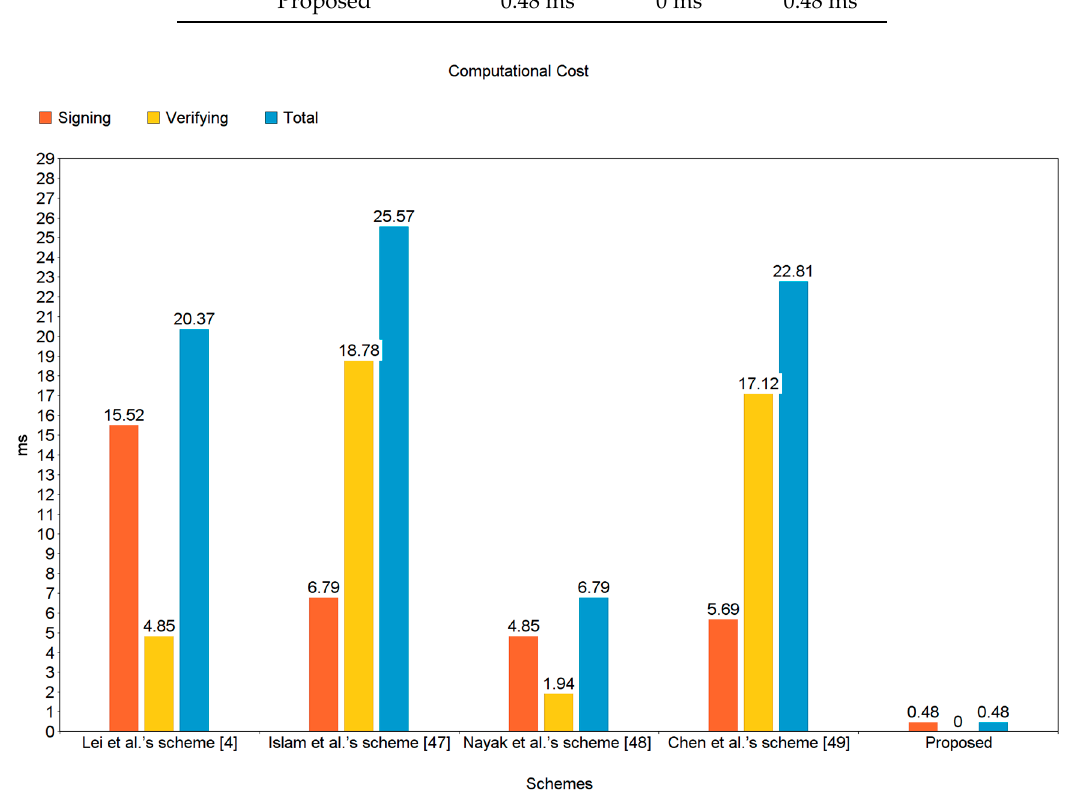
Figure 6. Computational cost (in ms).